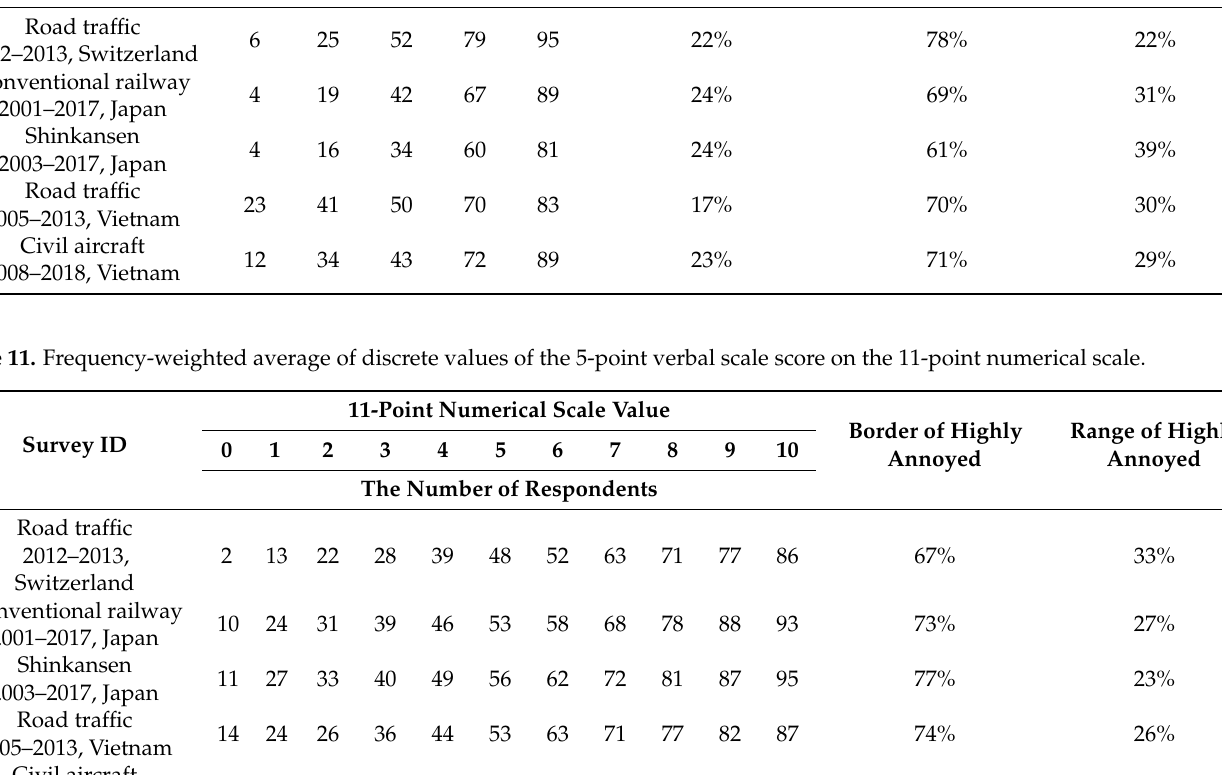
Table 10. Frequency-weighted average of discrete values of the 11-point numerical scale scores on the 5-point verbal scale. 5-Point Scale Value Border of Highly Range of Category 4